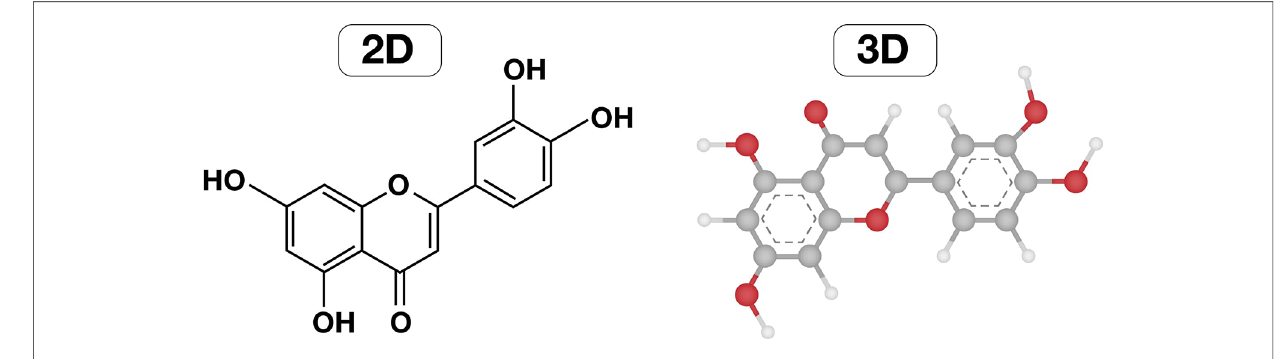
FIGURE 4 Chemical structure of luteolin in 2D and